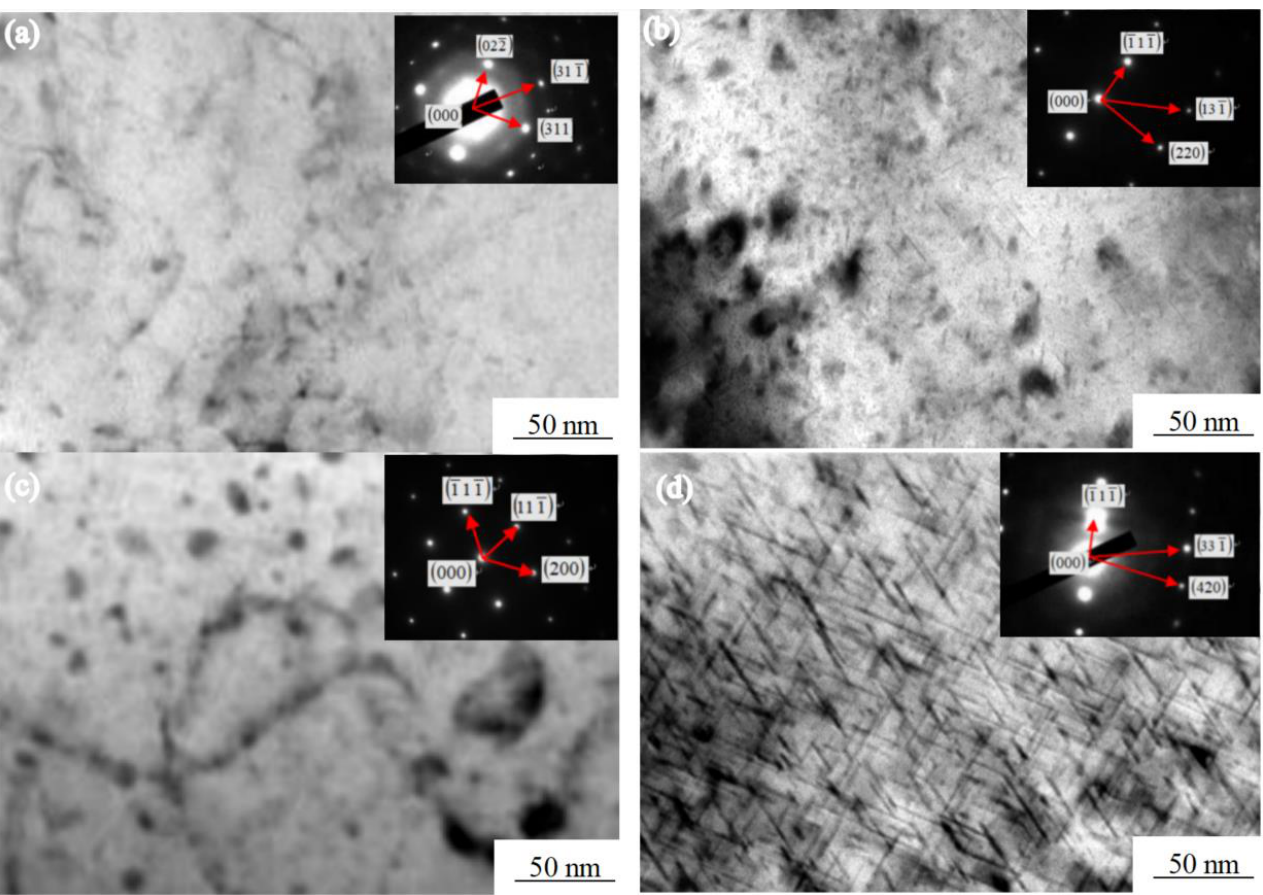
Figure 6. Morphologies of Mg 2 Si phase in Al-7.0Si-0.3Mg in aging processes: ( a ) 1 h, ( b ) 4 h, ( c ) 6 h, and ( d ) 8 h.